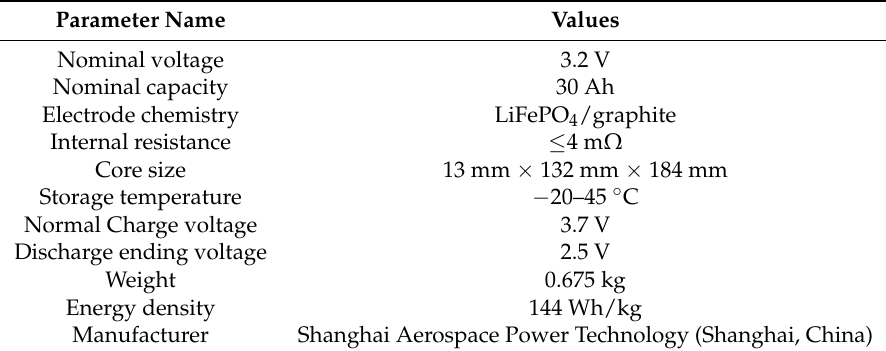
Table 1. Specifications of the lithium ion battery used.